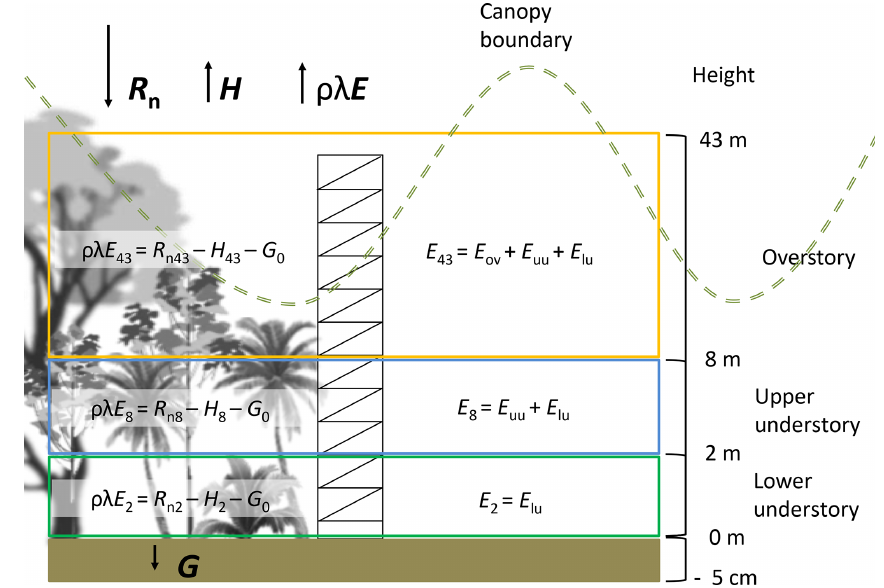
Figure 3. Diagram showing the distribution of canopy layers applied for the partitioning of energy and evaporation fluxes. This diagram also shows the components used for the estimation of the energy balance and its relationship with the estimates of